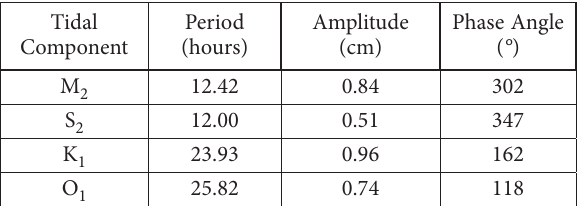
Table 1. Tidal forcing components as reported by Alpar and Yuce (1998). These correspond to mean spring and neap ranges of 3.4 and 2.7 centimeters respectively